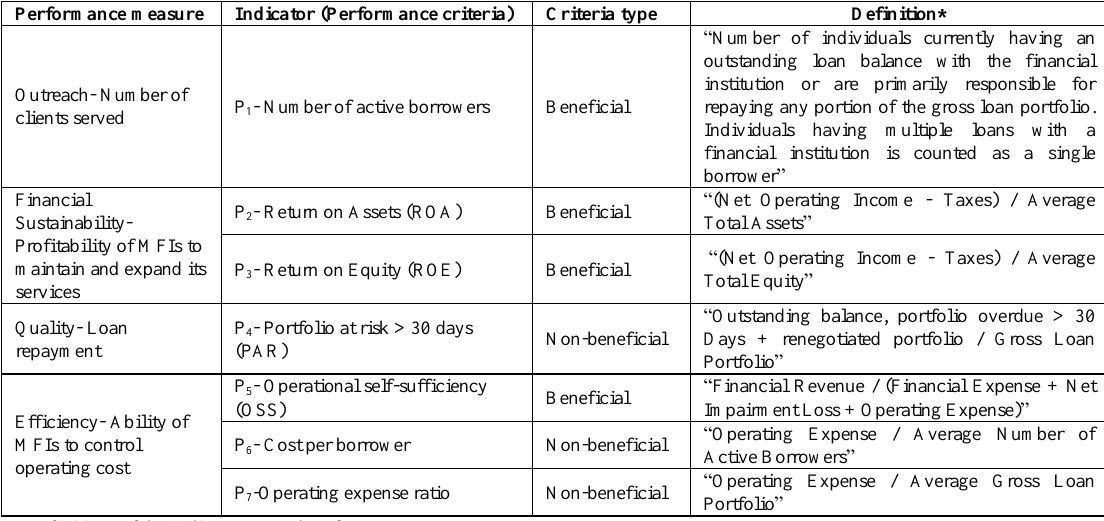
Table 1. Indicators of